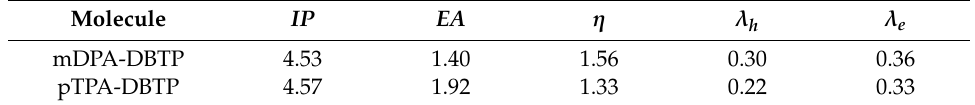
Table 1. The ionization potential IP (eV), electron affinities EA (eV), absolute hardness η (eV), hole reorganization energies λ h (eV), and electron reorganization energies λ e (eV) of two investigated molecules.